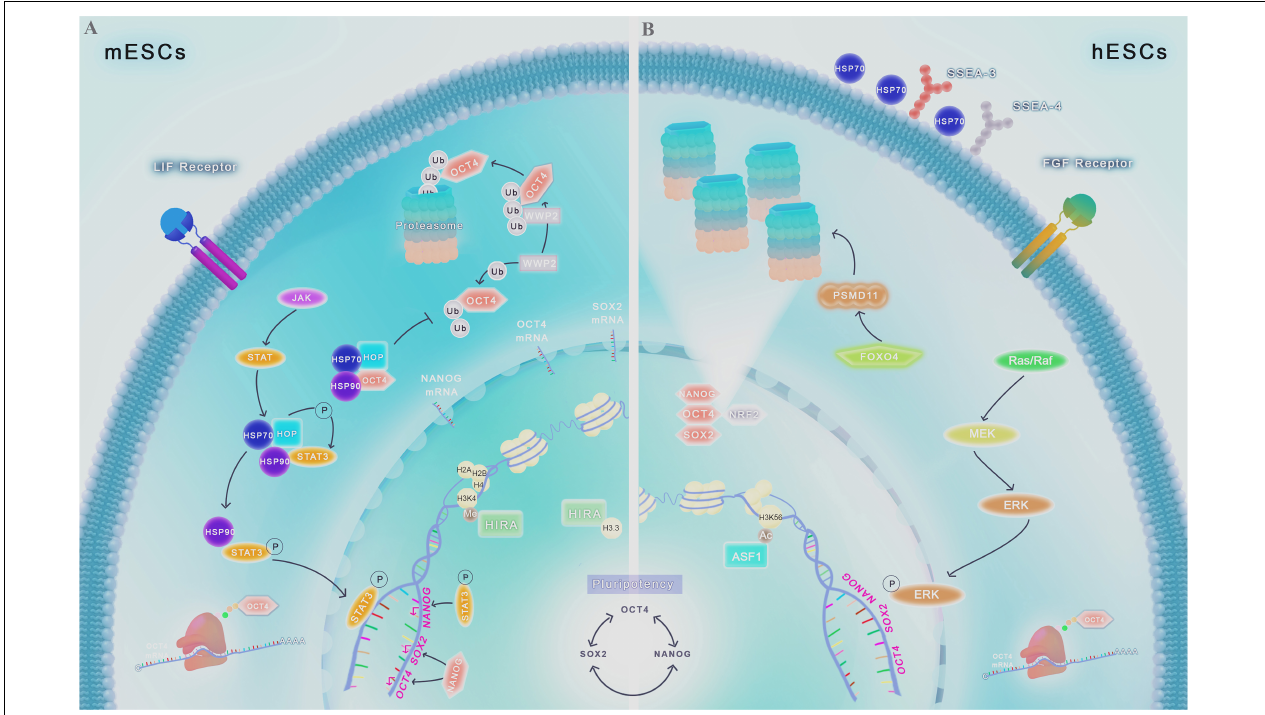
FIGURE 1 | Chaperome regulation and proteostasis network in ESCs. Scheme shows molecular pathways ranging from gene transcription to protein degradation involved in pluripotency control. The interconnected self-regulating nuclear core formed by OCT4, SOX2, and NANOG is essential for the maintenance of stemness. (A) In mESCs, HIRA is abundantly associated with promoter regions of developmentally regulated genes, being responsible for H3.3 deposition and enrichment, co-localizing with the transcriptional active form of methylated H3K4. Chaperone protein HSP90 and its partner HOP are engaged in key intracellular signaling pathways in PSCs, including LIF/JAK/STAT3. HSP90-HOP complex participates actively in the phosphorylation and translocation of STAT3 to the nucleus, leading to the transcription of pluripotency core factors. HSPs complexes can also prevent OCT4 degradation by proteasome. Proteasome-related proteins, such as WWP2, acting as E3 ligases or by other mechanisms, lead to TFs degradation by UPS, controlling its levels and maintaining proteostasis balance in these cells. (B) In hESCs, FGF2, used to culture these cells, activate the signaling cascade mediated by Ras/MEK/ERK and p-ERK translocation to the nucleus, favoring the expression of pluripotency genes. Acetylation of H3K56 by ASF1 regulates de expression of pluripotency genes. Unlike differentiated cells, HSP70 is present in the cell surface of hESCs, colocalizing with known pluripotency markers such as SSEA3 and SSEA4. Upregulation of the protein FOXO4 leads to the increase of the 19S proteasome subunit PSMD11, resulting in more functional proteasome subunits formed and increased activity of the UPS. The TF NRF2 upregulation is also associated with the increase in functional proteasome subunits, and also is associated with expression of the pluripotency TFs OCT4, SOX2, and